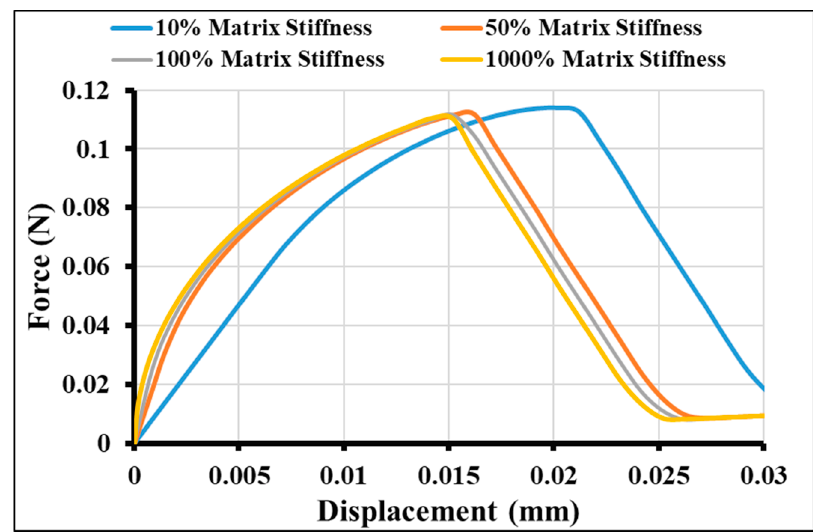
Figure 5. Force-displacement curve for varying interface stiffness.